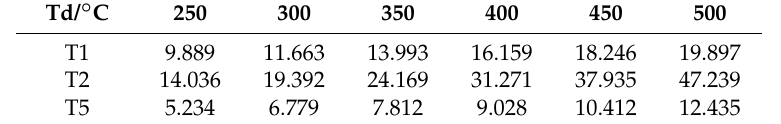
Table 3. Td (temperature difference) of T1, T2, and T5 under different bus voltages.